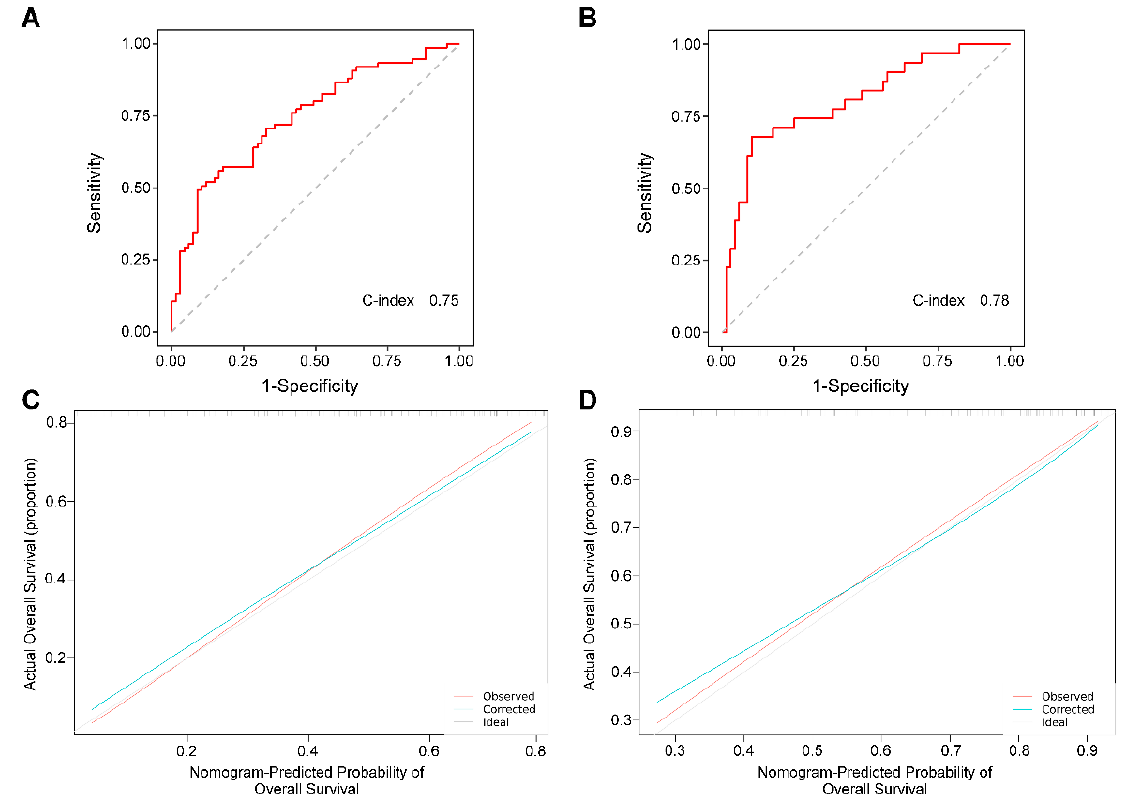
Figure 4. The C-index of the nomogram for the prognostic prediction of OS in the training cohort ( A ) and validation cohort ( B ). The calibration curves of OS based on nomogram prediction and the actual observation in the training cohort ( C ) and validation cohort ( D ).